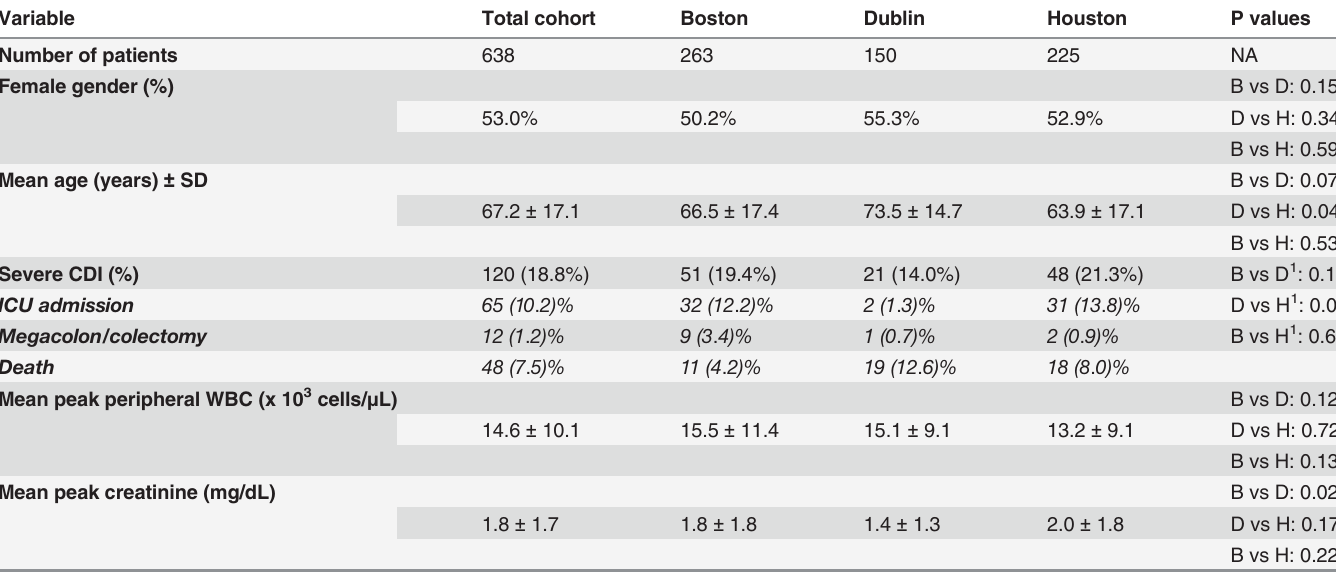
Table 3. Characteristics of patients in the Boston, Dublin and Houston